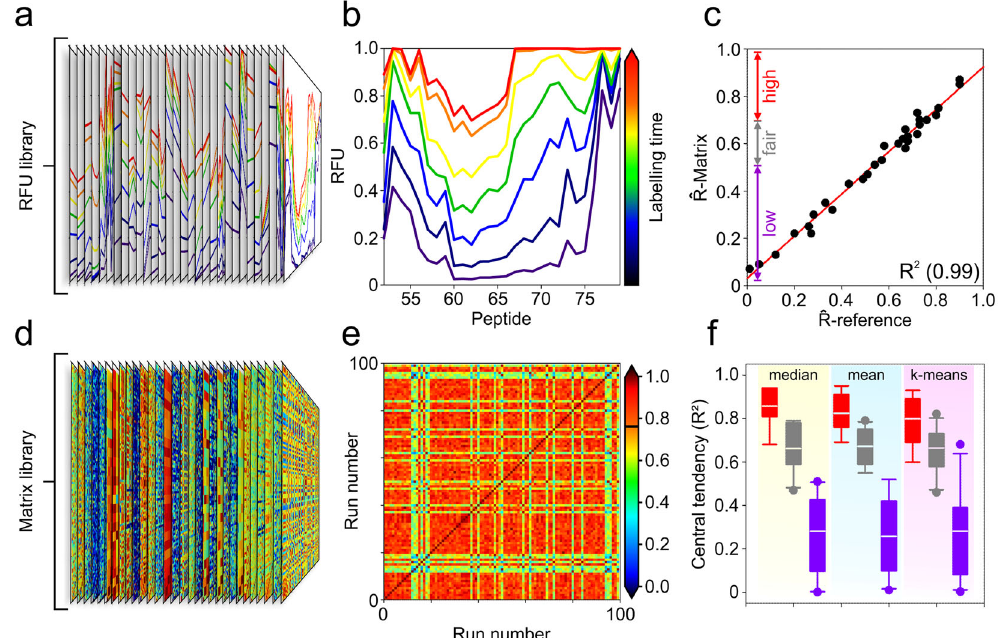
Fig. 2 Validating the accuracy of model lnP for data subsections. a , b Library of 30 different HDX-MS datasets used to validate R ̂ -matrix values obtained from the auto-validation matrices. An example reference dataset is shown displaying the RFU of different peptides at 7 different labelling times from 15 s (indigo) to 8 h (red). c Relationship between R ̂ -reference and R ̂ -matrix calculated following optimisation of the HDX-MS reference library. Three different classi fi cations are shown depending on whether the accuracy of modelled lnP values are predicted to be high (>0.7), fair (0.5 – 0.69), or low (<0.5). d , e Library of auto-validation matrices for reference data depicted ( a , b ). An example matrix is shown for an optimisation performed with 100 replicates ( n = 100) with each datapoint colour reporting the correlation coef fi cient between any 2 runs. The scalebar to the right of the plot reports the correlation coef fi cients of respective datapoints with the dark line across the scalebar denoting R ̂ -matrix, which is obtained from the average or all pairwise calculations. f Boxplot showing the distribution of R 2 between modelled and reference lnP calculated for each reference dataset. The plot shows the effect of different central tendencies, median, mean and k -means clustering on the R 2 with the data binned into three different classi fi cations as shown ( c ). Plot demonstrates the superior accuracy of the median for reporting the lnP of replicate optimisation runs along with an improved capacity to maintain separation between the high, fair, and low accuracy classi fi